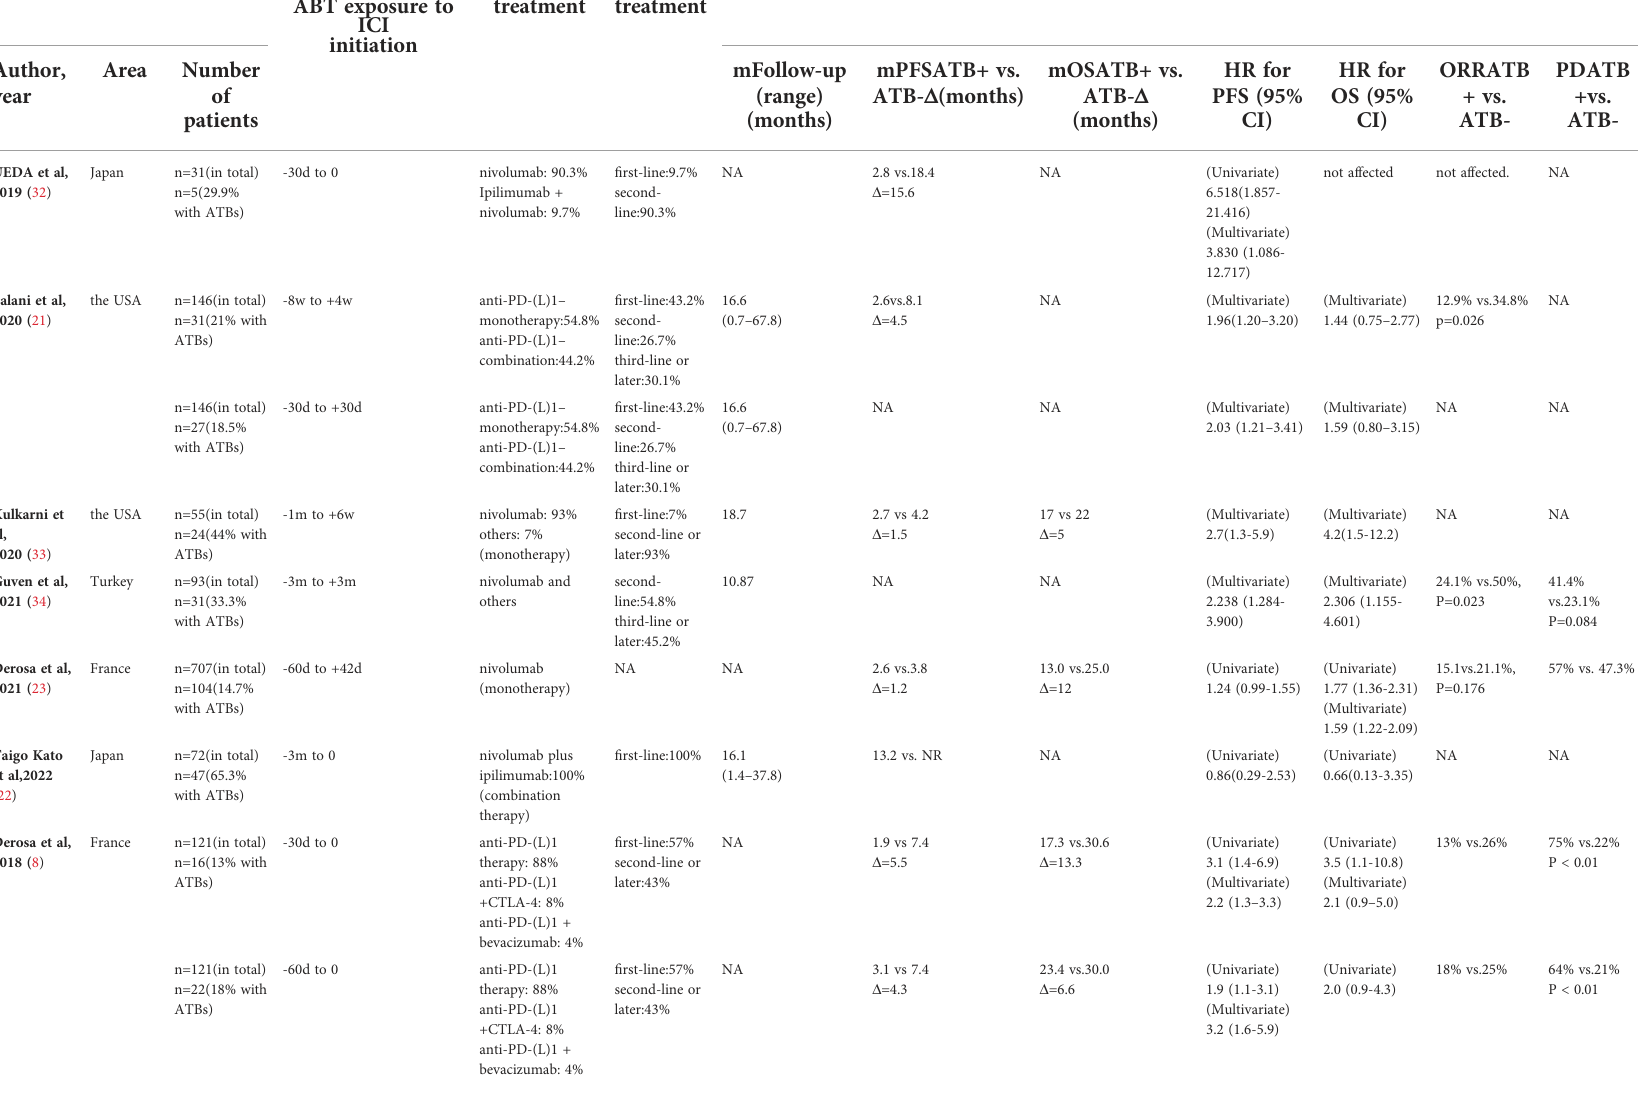
TABLE 1 Basic characteristics of included